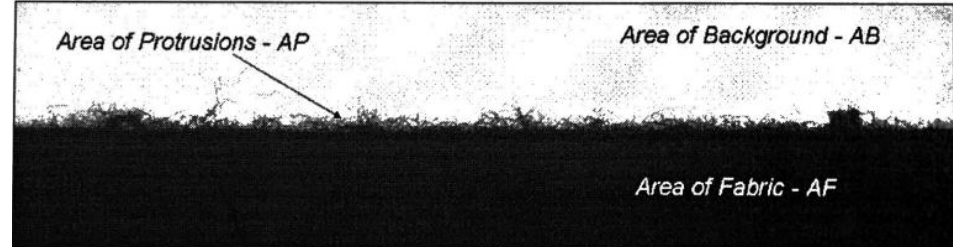
Figure 3. An example of one sample from the original study dataset [2,3].